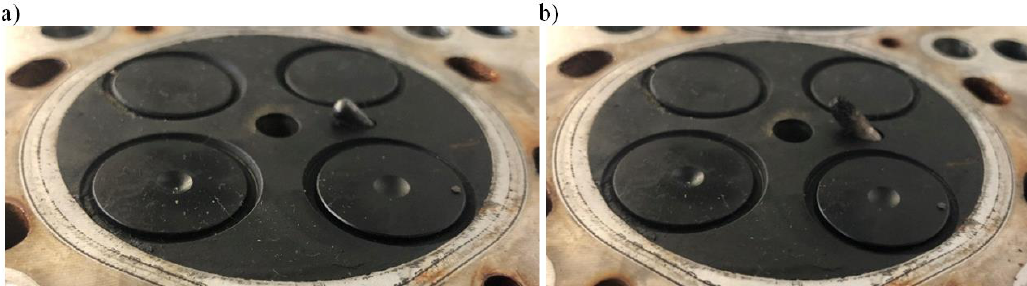
Figure 7. Heating part of the glow plug inside of the combustion chamber: standard ( a ), catalyst-covered prototype ( b ).